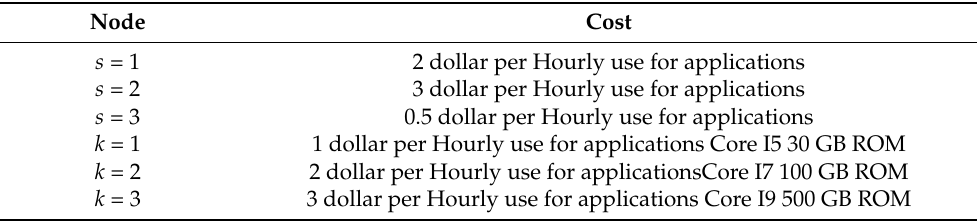
Table 4. Cost of Nodes.